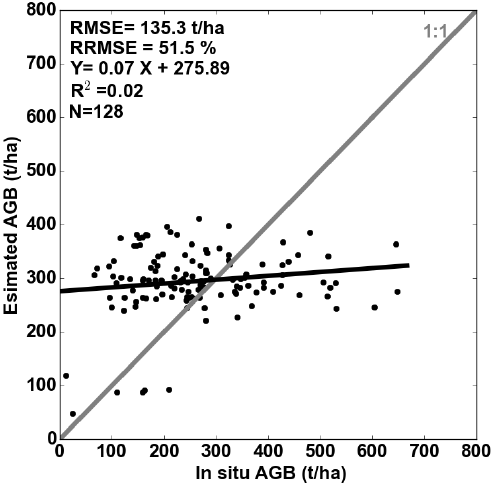
Figure 9 . Baccini’s approach AGB map as a function of in situ AGB. Figure 9. Baccini’s approach AGB map as a function of in situ